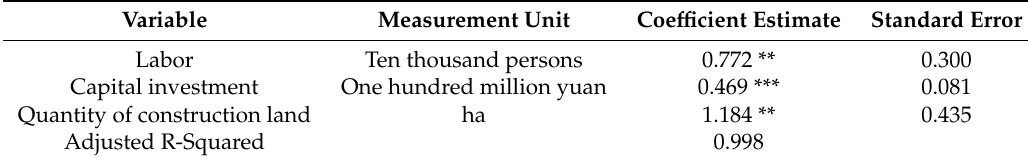
Table 3. Estimated Cobb–Douglas (C–D) production function for construction land and